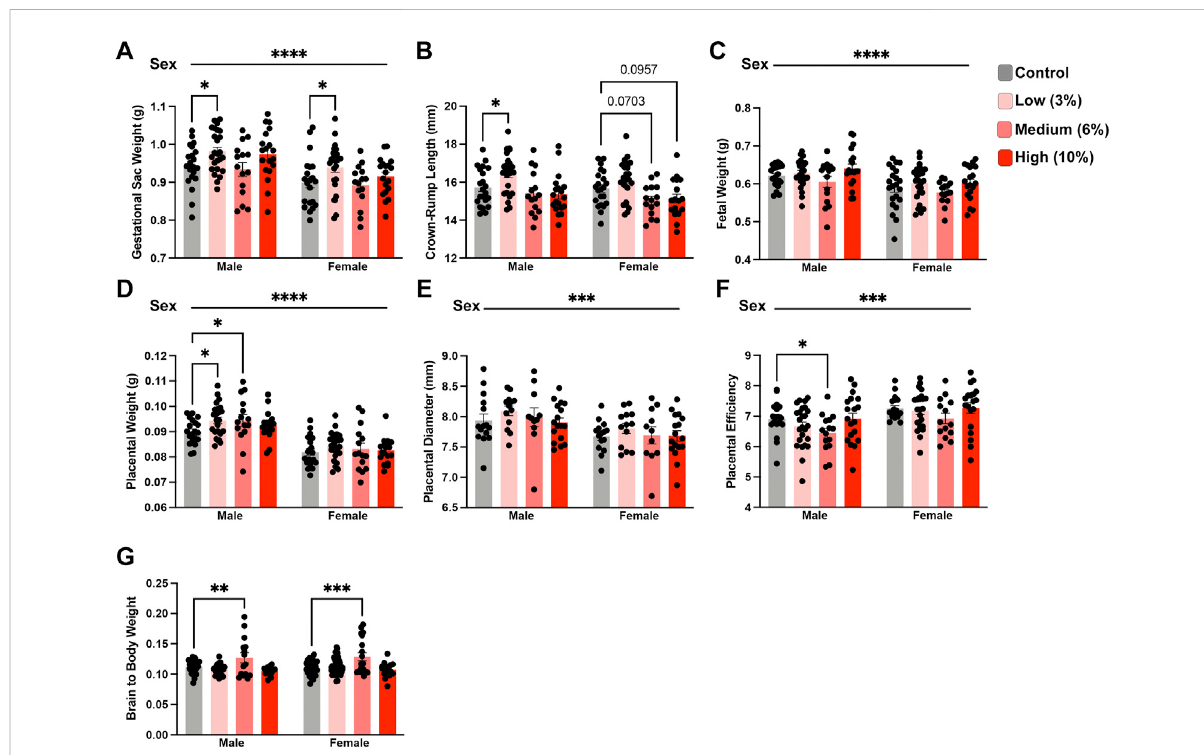
FIGURE 3 Paternal preconception alcohol exposure induces concentration-dependent changes in offspring fetoplacental growth. For all measures of fetoplacentalgrowth,weusedthemaleandfemaleaverageforeachlitterastheindividualstatisticalunit.Comparisonoflitteraverage (A) gestational sac weight, (B) crown-rump length, (C) fetal weight, (D) placental weight, (E) placental diameter, and (F) placental ef fi ciency between offspring sired by males across treatment groups (A – D/F. n = litter average with males: 20 Control, 24 Low, 15 Medium, 18 High litters; females: 21 Control, 25 Low, 15 Medium, 18 High litters; (E) n = litter average with males and females: 15 Control, 13 Low, 11 Medium, 17 High litters). (G) Comparison of normalized brain weights in the offspring of alcohol-exposed males across treatment groups ( n = fetus, randomly selected from each litter, males: 28 Control, 33 Low, 15 Medium, 16 High; females: n = 29 Control, 51 Low, 19 Medium, 17 High). We used either a two-way ANOVA to contrast the impacts of sex and preconception treatments or Brown-Forsythe and Welch ’ s one-way ANOVA. Sex differences are indicated above the fi gures, while treatment effects are demarcated directly above the bar graphs. Error bars represent the standard error of the mean, * p < 0.05, ** p < 0.01, *** p < 0.001, **** p <